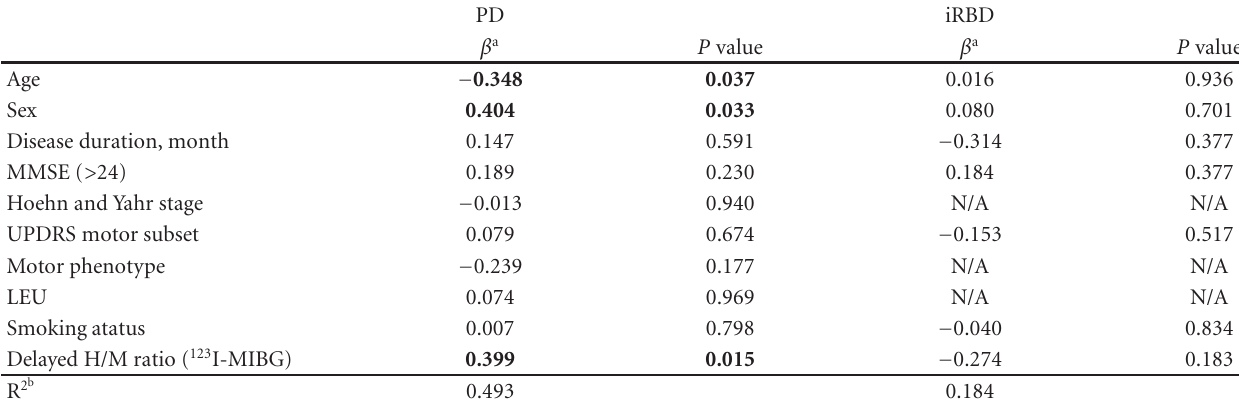
Table 2: Multiple regression analysis of OSIT-J related parameters for Parkinson’s disease ( N = 38) and iRBD ( N =